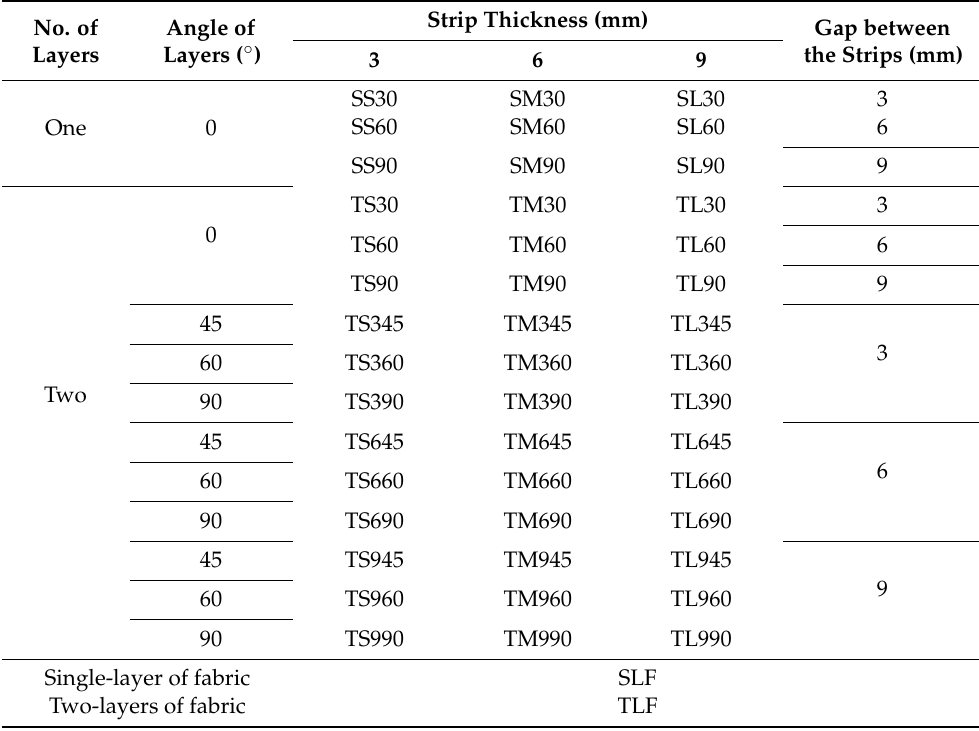
Table 2. Cu/Ni NW sample and its code.